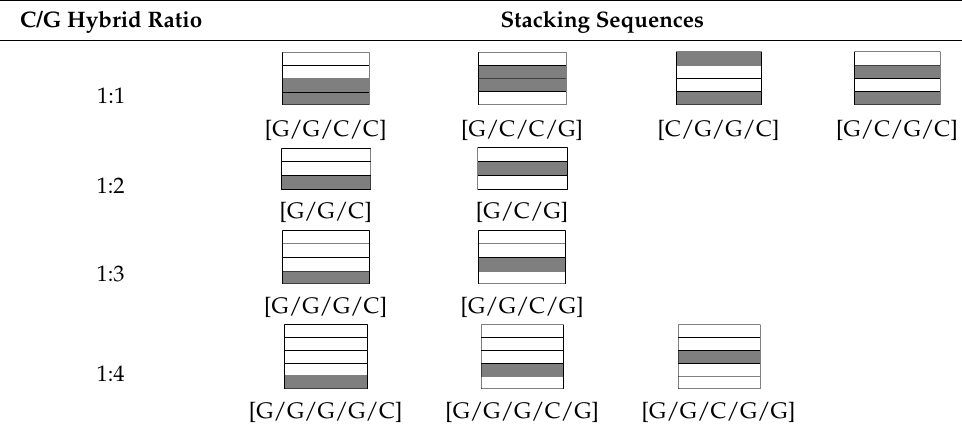
Table 3. Stacking configurations of interlayer hybrid structures. C/G Hybrid Ratio Stacking Sequences